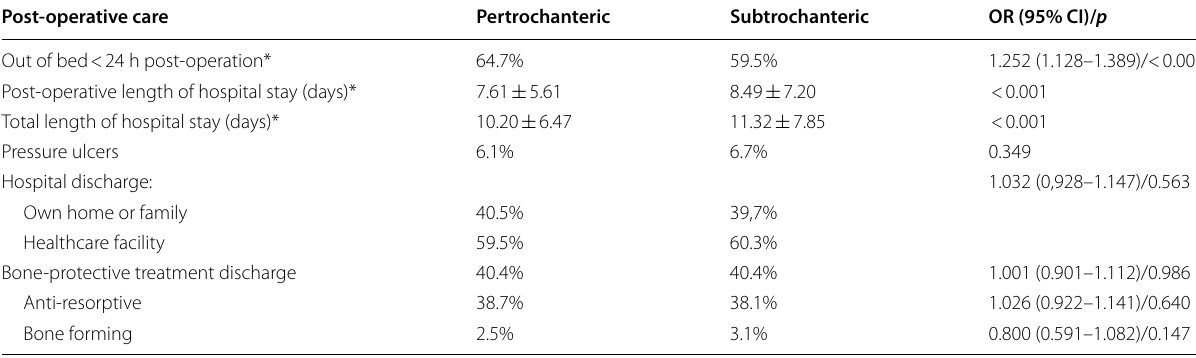
standard deviation and percentage ±